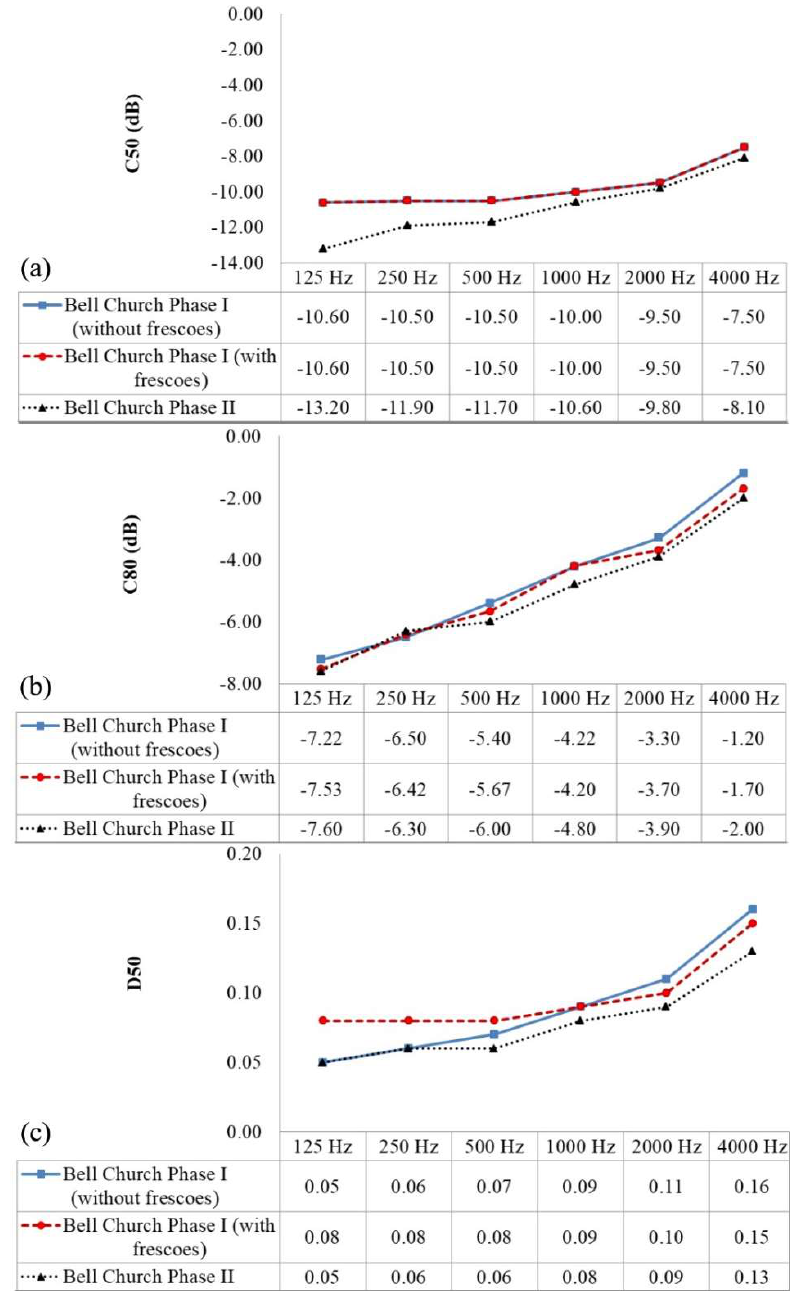
Figure 16. ( a ) C50; ( b ) C80; ( c ) D50 obtained over 1/1 octave bands for Bell Church Phase I & II. Negative C50 values are observed in all phases of the church. The values of C80 increase with increasing octaves, with Phase II showing a mean C80 value of around −5.40 dB. The low D50 values observed are due to high reverberation in the space.